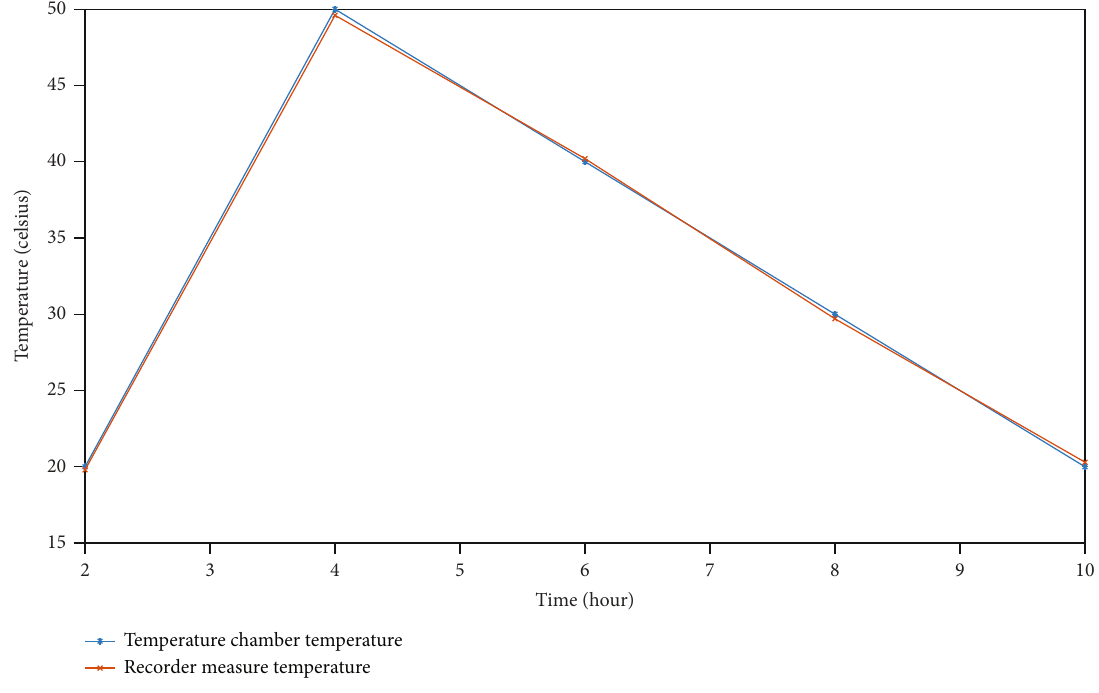
Figure 13: Temperature curve of environmental